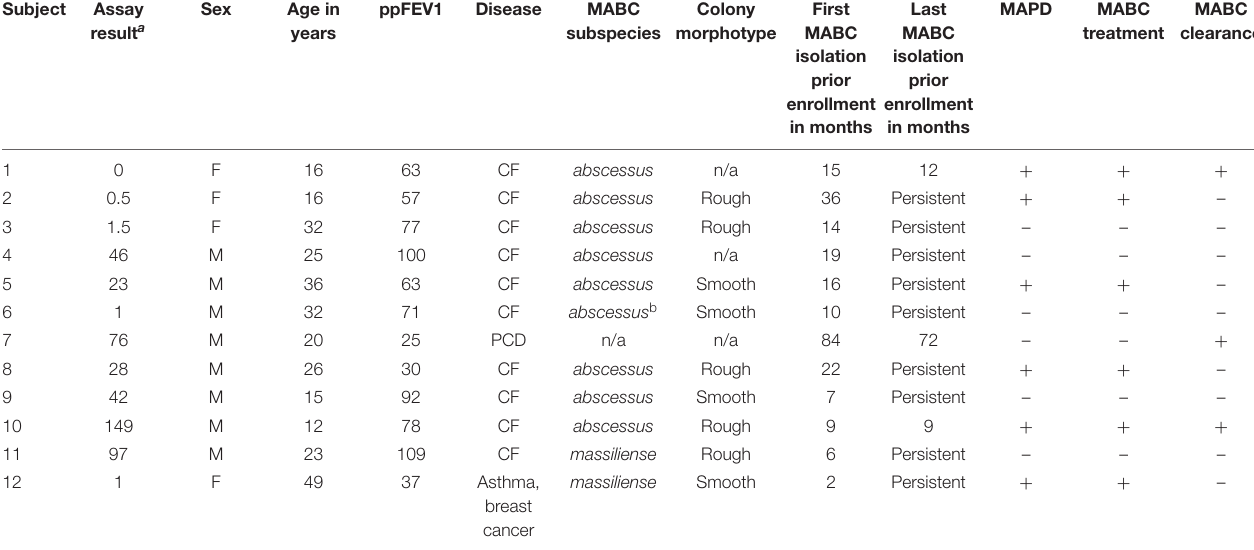
TABLE 3 | Subject characteristics of M. abscessus complex positive